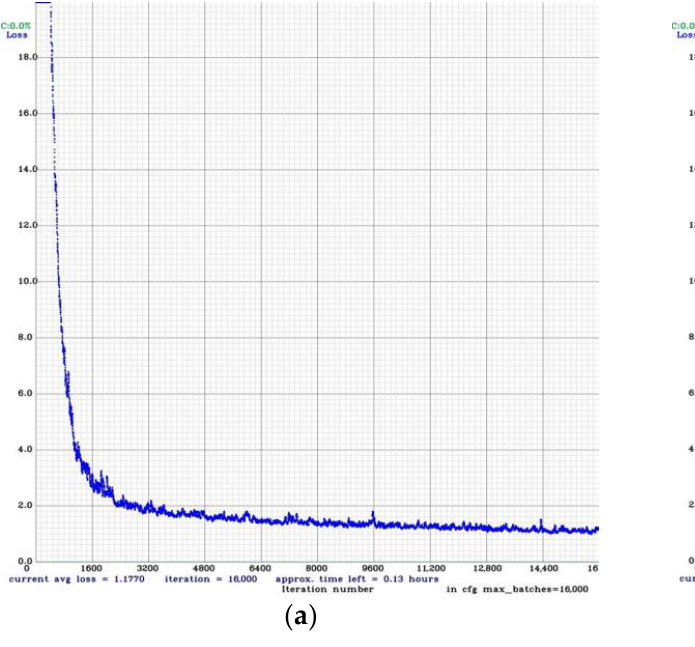
Figure 13. Average loss results of AI models training on different iterations: ( a ) Average loss 1.1770 after training YOLOv3-HSV model; ( b ) Average loss 0.5875 after training YOLOv3-Augment model.